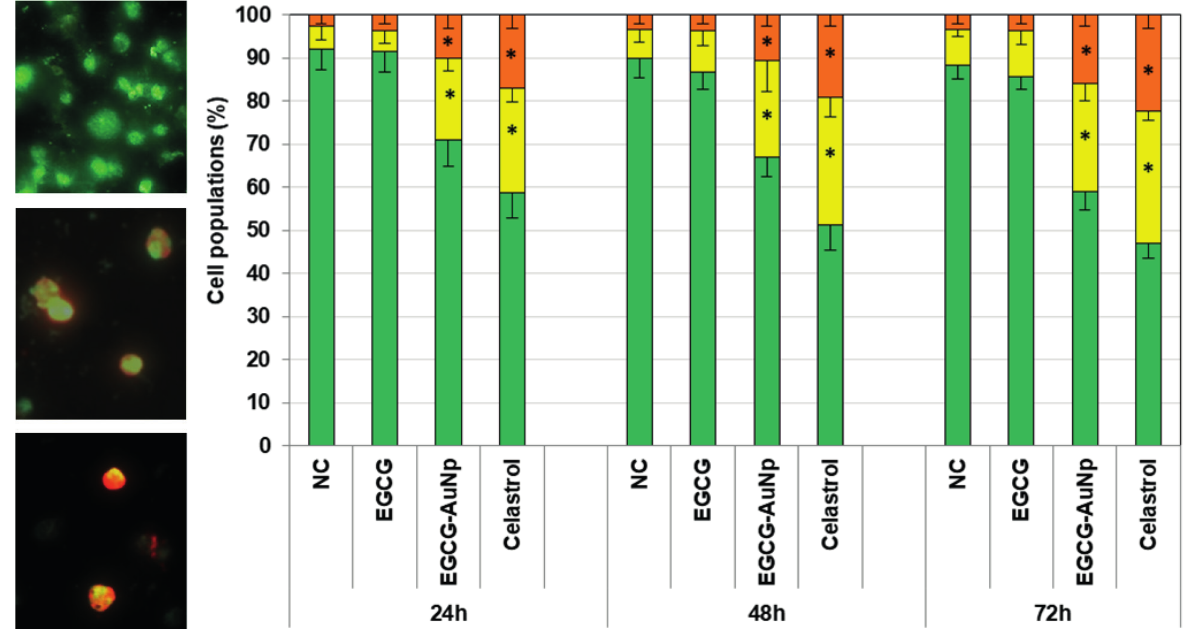
Figure 3. a. Photomicrographs representing control, apoptotic, and necrotic HepG2 cells (from top to bottom). b . A histogram indicates the distribution of vital (green segments), apoptotic (yellow segments), and necrotic (red segments) HepG2 cells, after being treated with 30% of IC concentrations of EGCG, EGCG-AuNPs, and celastrol, 50 compared with untreated control. Statistical analysis was performed using Graphpad Prism V6.01.*signifi cance compared with untreated control at each respective time point, at P <